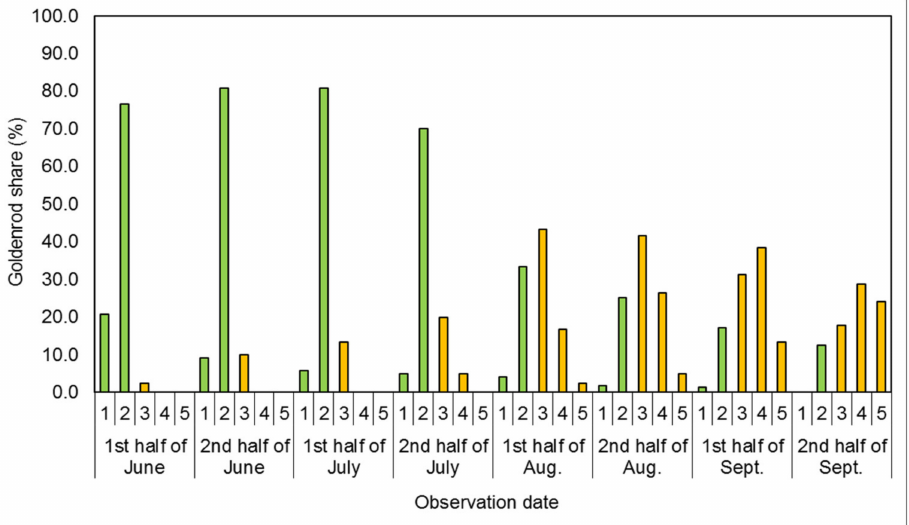
Figure 1. Mean share of goldenrods in successive developmental stages covering the plots’ surfaces in the control treatment (C). In Figures 1–5, vegetative stages are marked green, while generative stages are orange, and the numbers mark the successive stages of the goldenrods’ development: (1) emergence and early vegetation, (2) development of shoots, (3) formation of inflorescences, (4) flowering, and (5) fruiting and shedding of